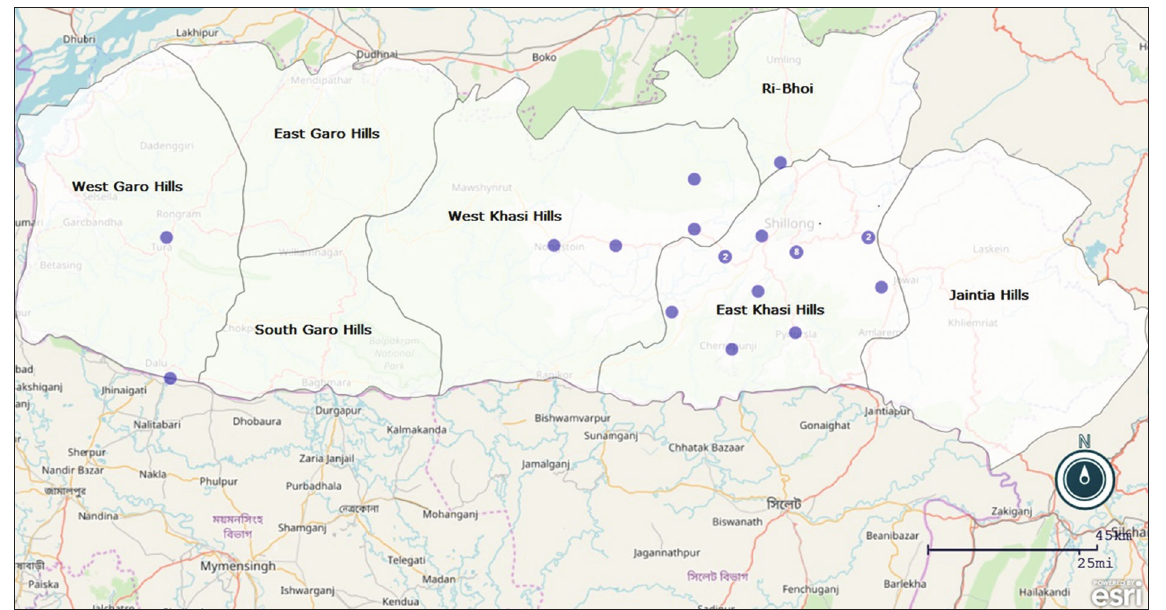
Figure-1: Map of Meghalaya indicating the location of the pig farms from where samples were collected during the period of 2014-2016. The numbers in the dots represent the number of farms located in that